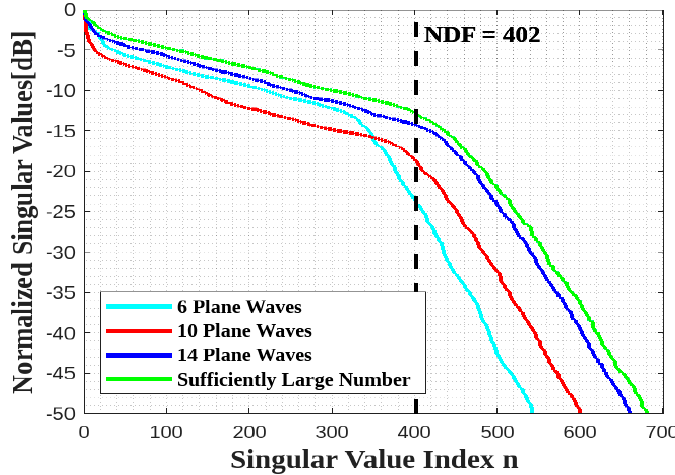
Figure 14. Comparison of the behavior of the normalized singular values for different numbers of impinging plane waves for the L shape ID.